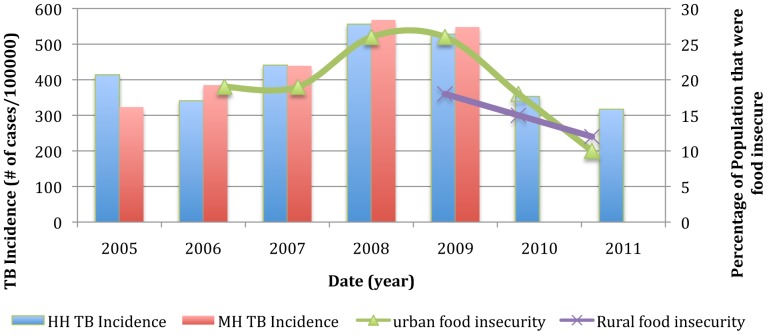
TB incidence at HH and MH versus rural and urban food insecurity.Consistent with the belief that food insecurity contributed to rise in TB, the figure shows an increase in food insecurity during the crisis and then a fall afterwards in urban environments. This parallels the rise in TB incidence during the crisis and the decrease seen after. Rural food insecurity was also seen falling after the crisis. Data for rural food insecurity during the crisis was not available. Source Urban and Rural food insecurity: Famine Early Warning Network [12].